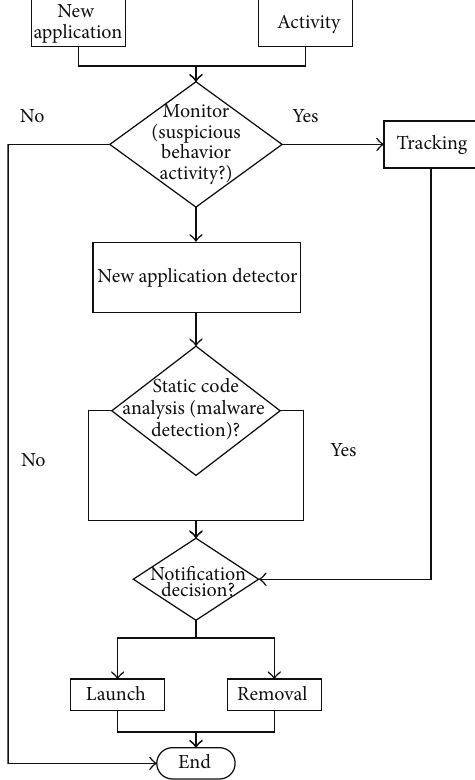
Figure 6: Flowchart of the